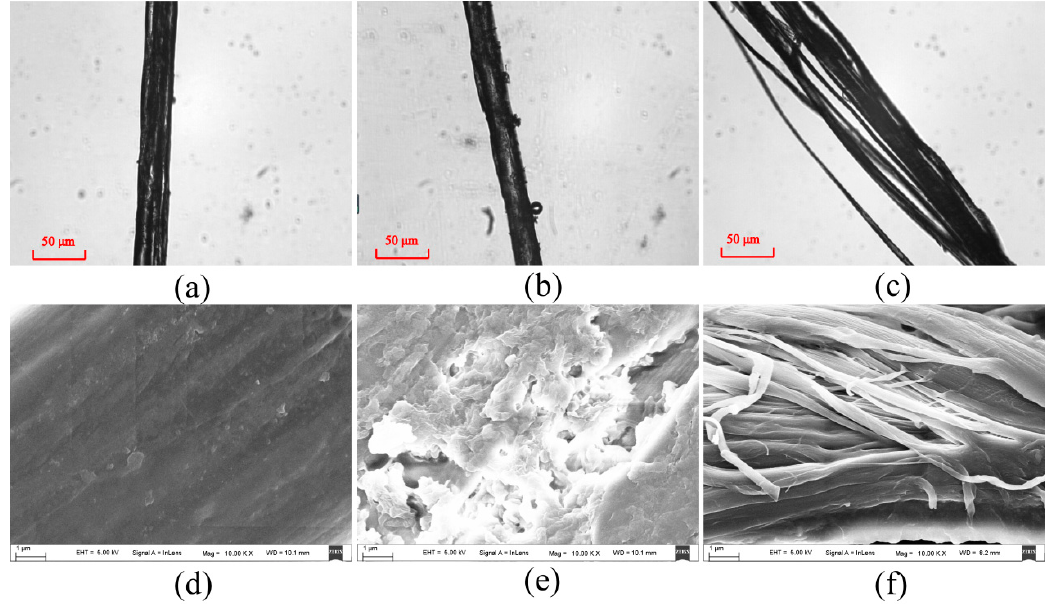
Figure 7. Optical microscopic images of silk samples in group B: ( a ) before washing; ( b ) after the sixth washing by toilet soap; ( c ) after the sixth washing by color stain net. Scanning electron microscopic images (10,000×) of silk samples in group B: ( d ) before washing; ( e ) after the sixth washing by toilet soap; ( f ) after the sixth washing by color stain net.